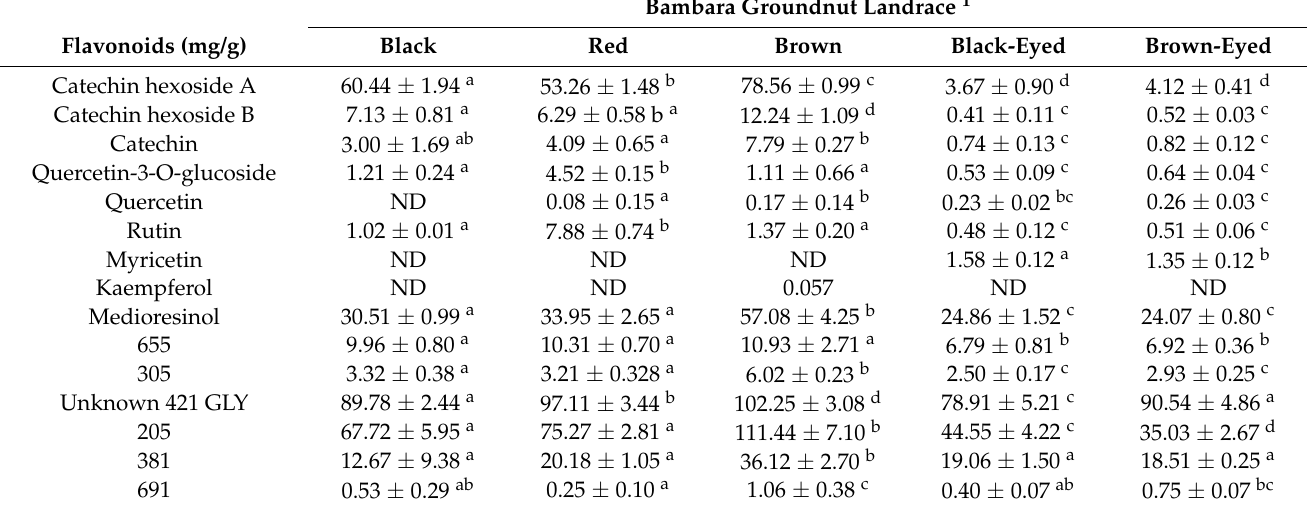
Table 1. Flavonoids detected in ethanolic extracts of the whole seeds of five different Bambara groundnut landraces.